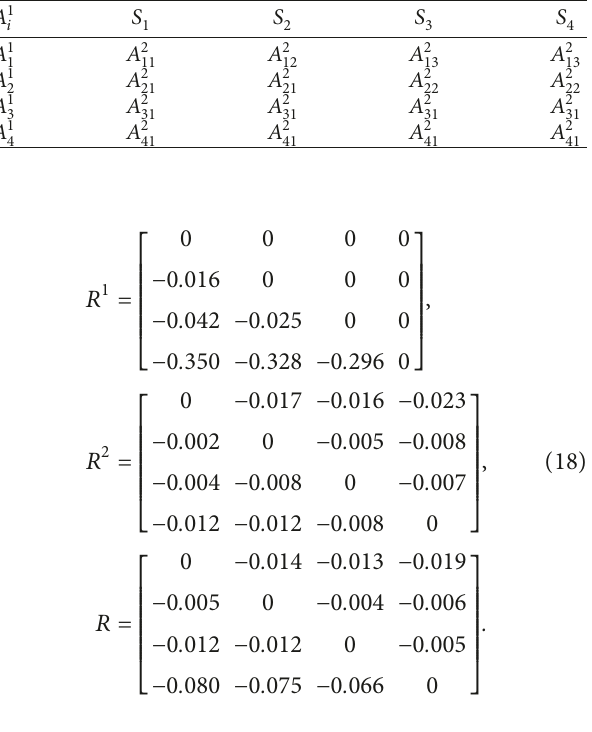
Table 4: The optimal responding measure when conducting and scenario appears in time t measure A 1 i in time t 1